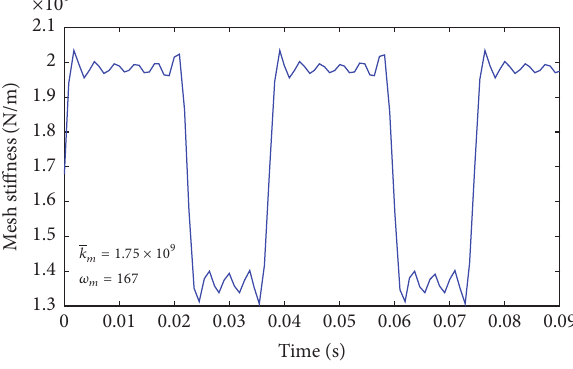
Figure 6: Time-varying mesh stiffness.